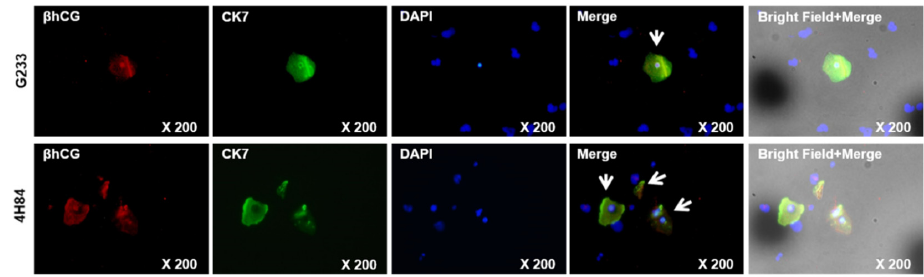
Comparison of expression patterns of HLA-G in trophoblast cells captured by G233 (top) and 4H84 antibody (bottom). More β -hCG and CK7 expressing cells were identified in the cells captured by the 4H84